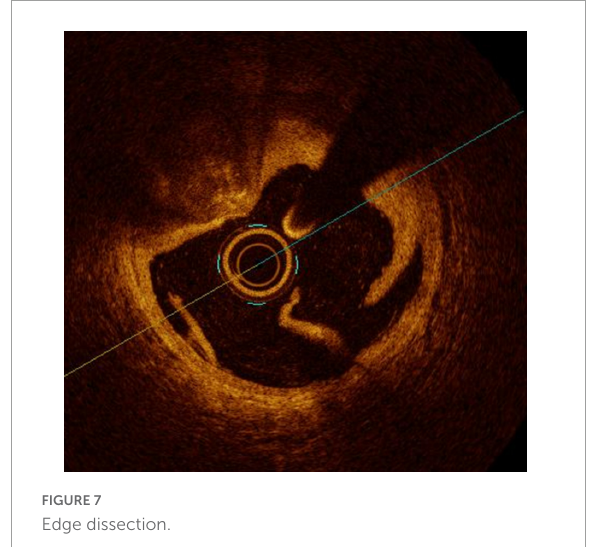
FIGURE7 Edge dissection.